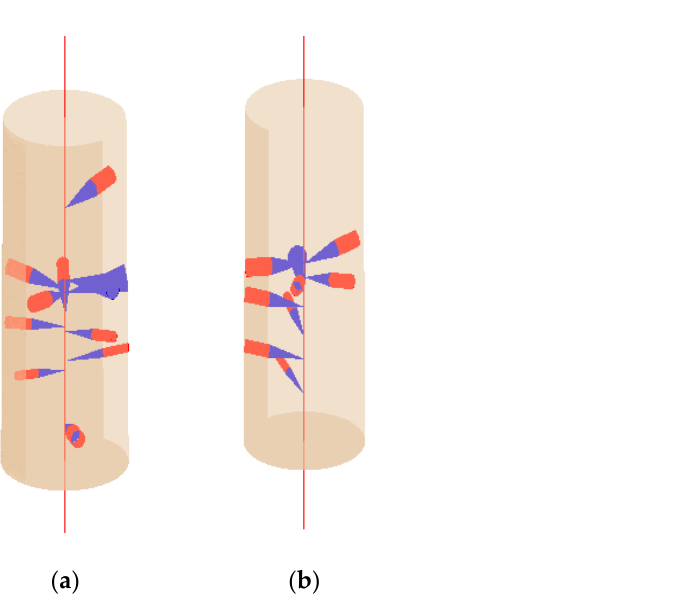
Figure 6. Example of veneer knot map.